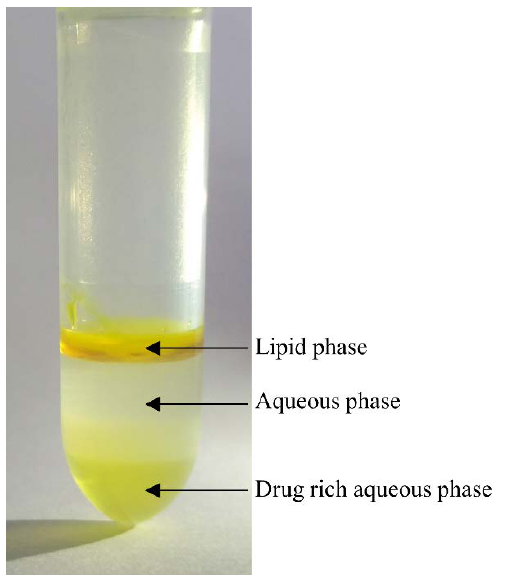
Figure 5. In vitro lipolysis sample of sLBF after ultracentrifugation. Four phases were present: lipid phase, aqueous phase, solid phase (not shown) and drug-rich aqueous phase.